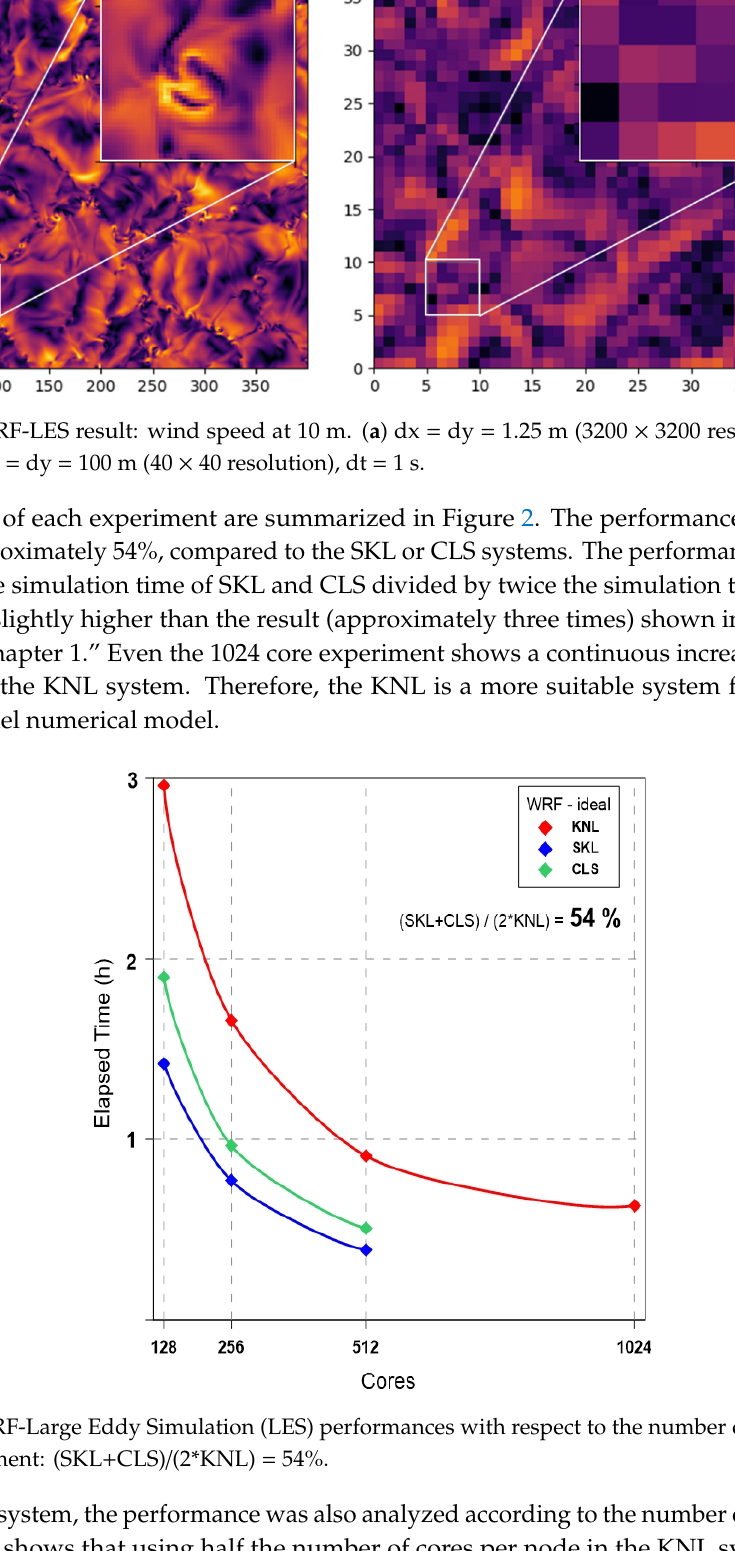
Figure 1. WRF-LES result: wind speed at 10 m. ( a ) dx = dy = 1.25 m (3200 × 3200 resolution), dt = 0.01 s. ( b ) dx = dy = 100 m (40 × 40 resolution), dt = 1 s.